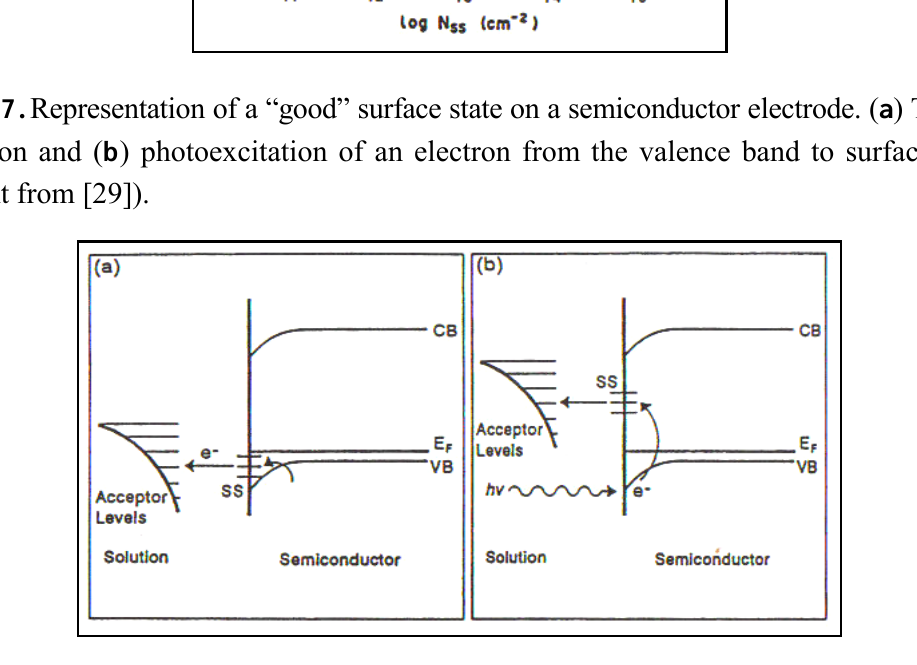
Figure 8. A schematic representation of a p -type semiconductor/solution interface (Reprint from [29] and